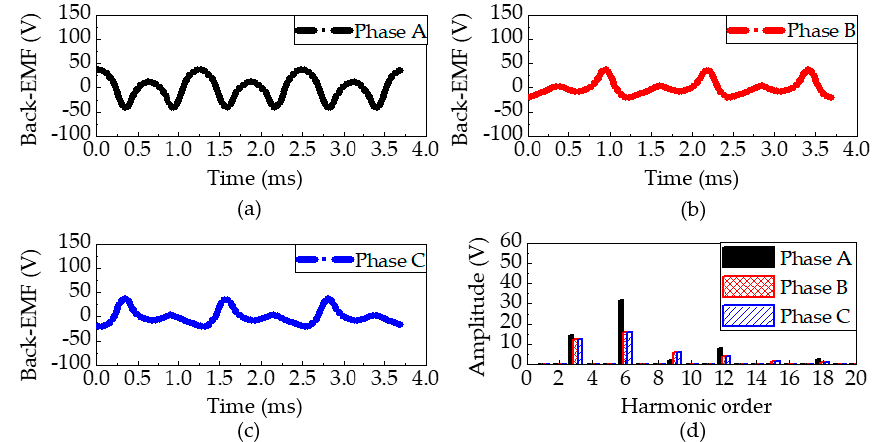
Figure 7. Characteristics of no-load back-EMF with 0 Hz in the outer winding when the output rotor and the inner winding operate at 124 rpm and 270 Hz, respectively: ( a ) Waveforms of phase A; ( b ) Waveforms of phase B; ( c ) Waveforms of phase C; ( d ) Time harmonic spectra.